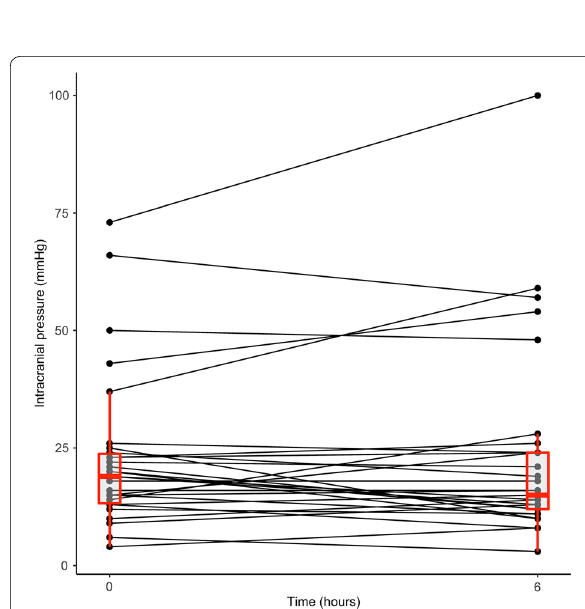
Fig. 3 Intracranial pressure changes after a natremia correction rate higher than 0.5 mmol/L/h (during 6 h). The red boxplots correspond to the median ICPs and interquartile ranges at the start and at the end of the six-hour period (three patients with raised ICPs of 37, 43 and 73 mmHg at time 0 increased their ICPs up to 59, 54 and 100, respectively, 6 h after. They died early at day 2, 3 and 4, respectively, suggesting their DI was related to brain